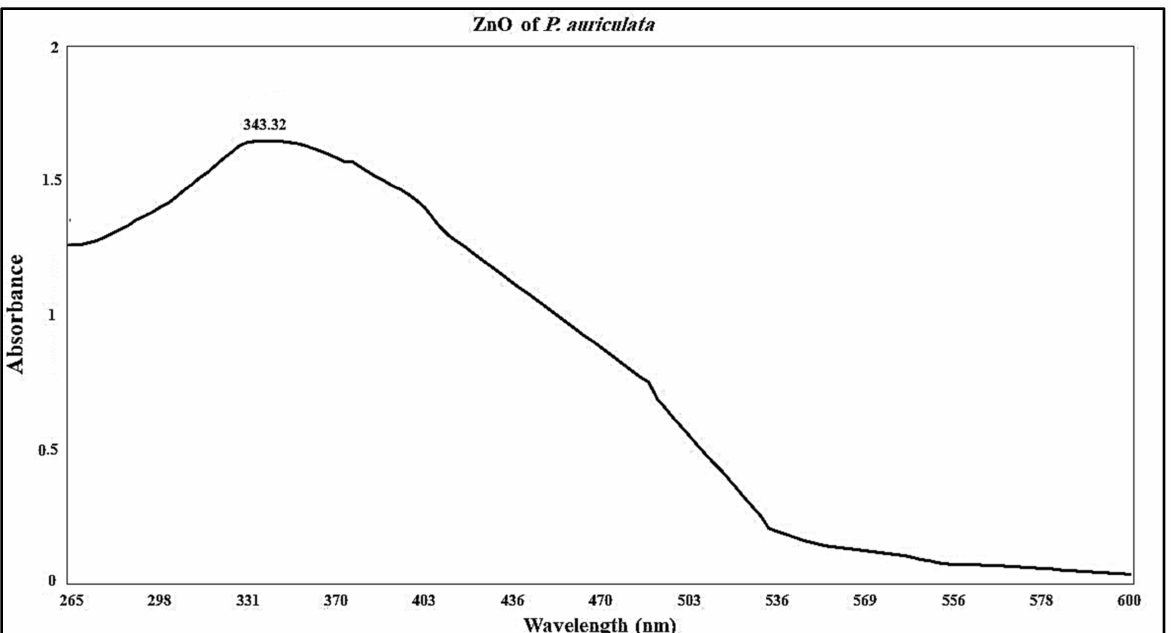
Figure 3. UV spectrum of biosynthesized ZnO